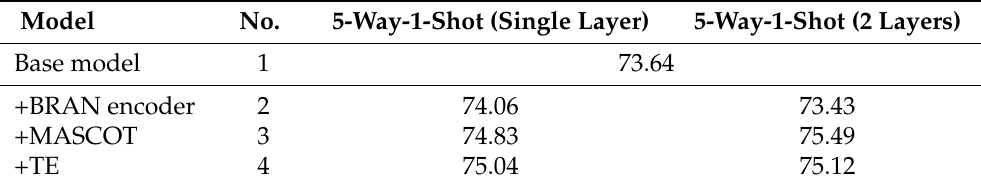
Table 8. Encoder performance comparison; BRAN represents the bi-affine relation attention networks, MASCOT is our proposed multi-head self-attention with convolution Encoder, and TE represents the standard Transformer Encoder.